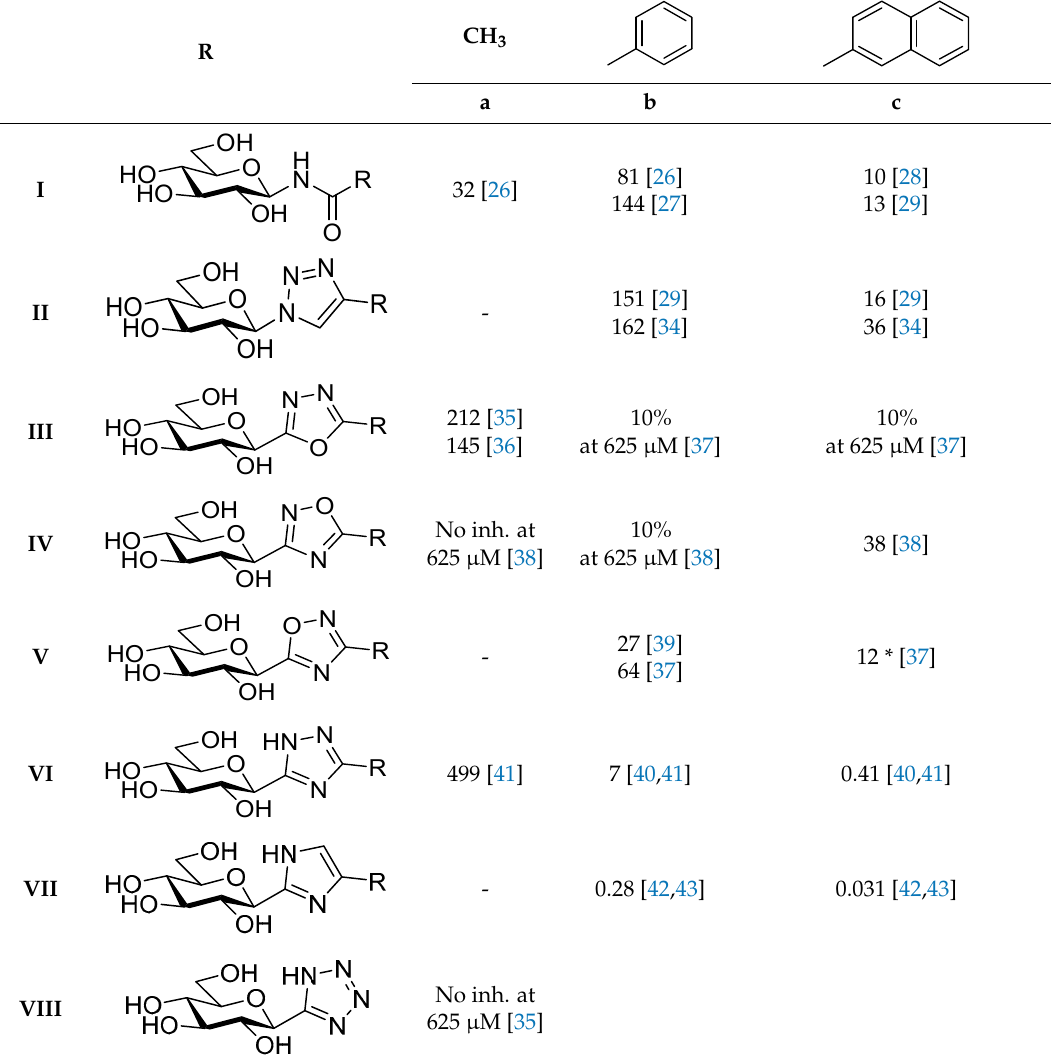
Table 1. Selected glucose derived inhibitors of rabbit muscle glycogen phosphorylase b ( K i [ μ M]). CH 3 R R R R CH 3 R CH 3 R R CH 3 R CH 3 CH 3 CH 3 CH 3 R CH 3 CH 3 R R R R R R R a b c a b c a b c I I I O O O O O I I I I I II N N OH O O II R II N II O III O R III